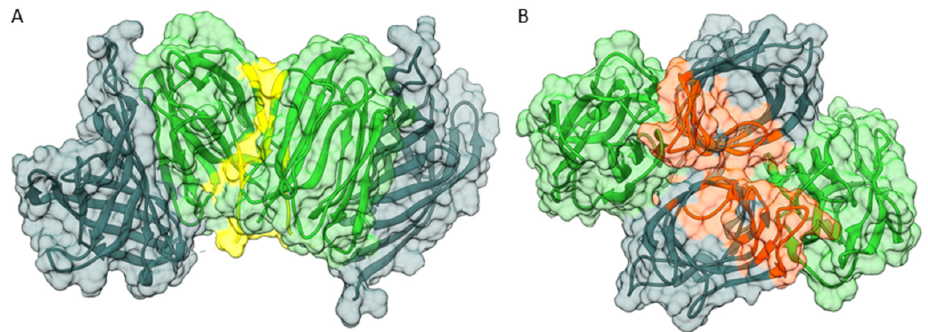
Figure 7. Analysis of Os JAC1 oligomerization through protein–protein docking using HADDOCK [34], featuring potential dimers of the full-length protein in transparent surface view with DIR (metallic) and JRL domain (green) ribbon models. ( A ) Active residues were selected according to the interface of the JRL homo ‐ dimer observed in our crystal structures. Interaction is mediated exclusively by the JRL domains (interface highlighted in yellow). ( B ) Active residues were selected according to the interface of the DIR homo ‐ trimer observed in our crystal structures. Interaction is dominated by the DIR domains but also includes significant DIR ‐ JRL contacts (highlighted in orange).